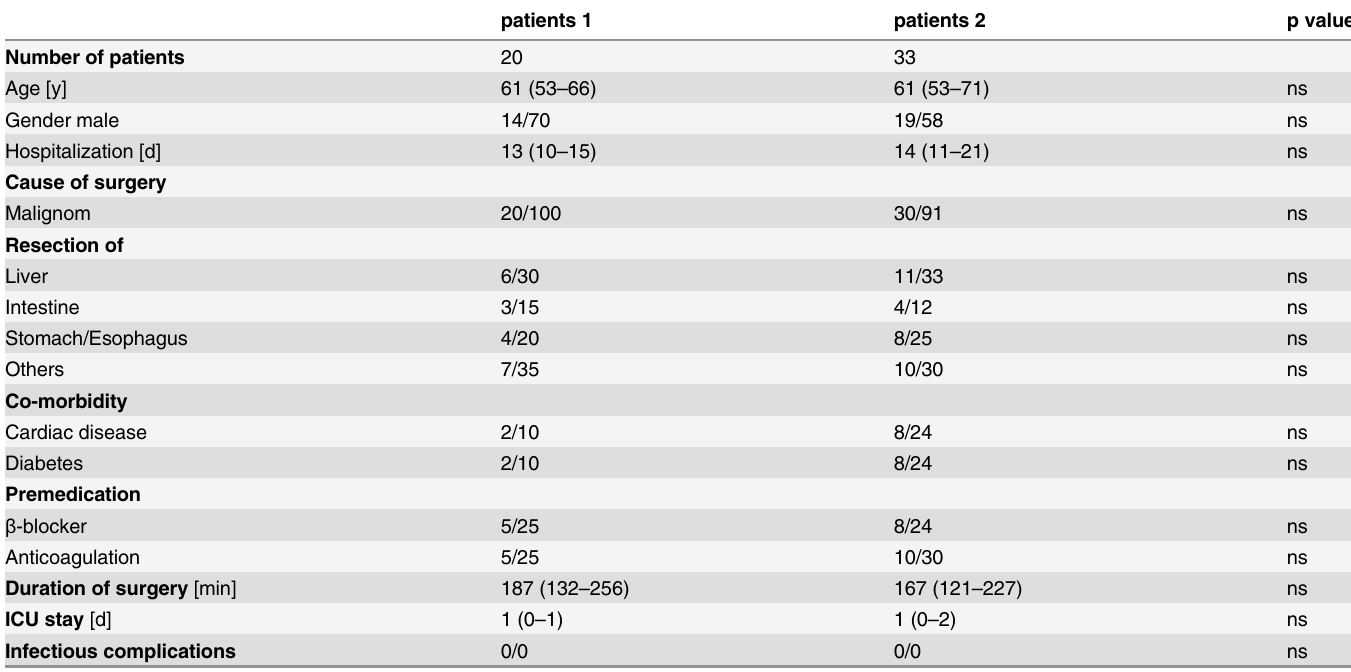
Table 1. Patients ’